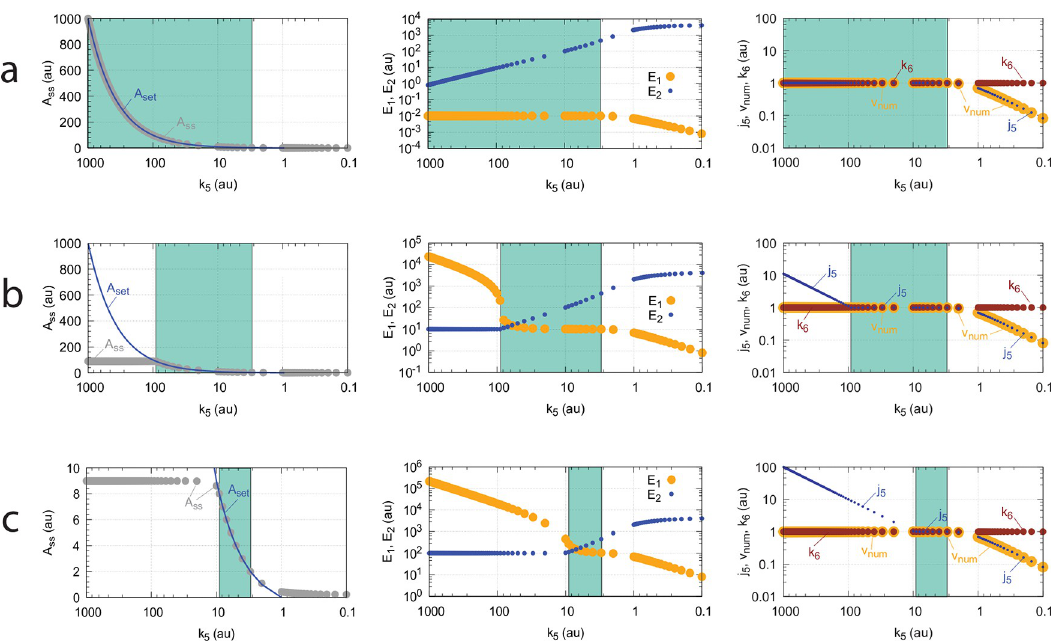
Fig 22. Operational range of the controller from Fig 19 as a function of k 5 and the ratios ( k 10 / k 9 )=( k 12 / k 11 )=( k 14 / k 13 )=( k 16 / k 15 ). A set in the left panels is the theoretical set-point described by Eq 56. A ss (gray dots) are the numerically calculated steady state values of A . Middle panels show the concentrations of E 1 and E 2 indicated by blue and orange dots, respectively. Panels to the right show (yellow dots) is the numerically calculated degradation the flux j 5 (small blue dots) which generates E 1 by A -repression (Eq 56). v num velocity of the ternary-complex. Dark red dots show k 6 . Turquoise areas indicate the controllers operational range when Eq 56 is satisfied. (a) k 9 = k 11 = k 13 = k 15 =1 × 10 8 . (b) k 9 = k 11 = k 13 = k 15 =1 × 10 5 . (c) k 9 = k 11 = k 13 = k 15 =1 × 10 4 . Remaining rate constants and initial concentrations are as in Fig 20.